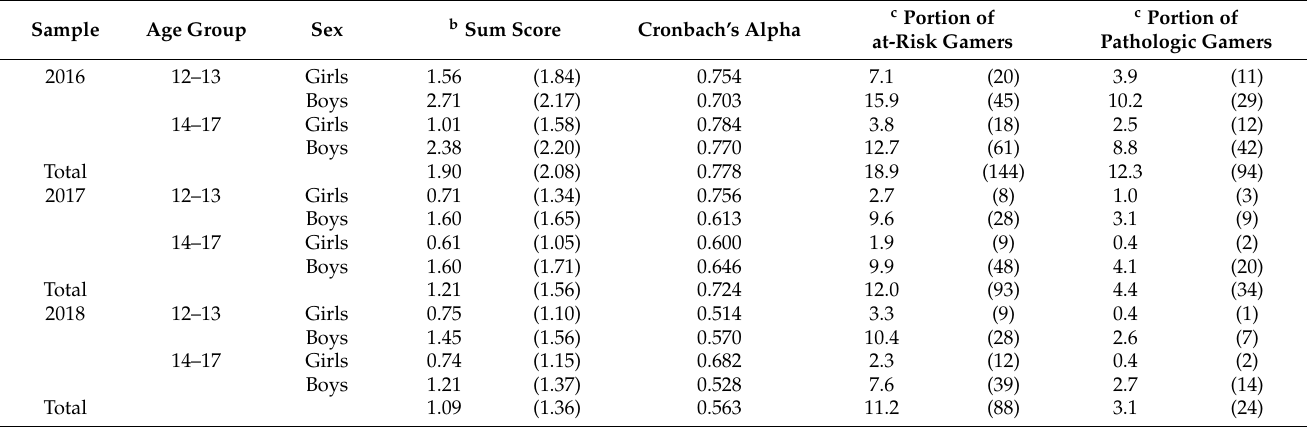
Table 2. Internet Gaming Disorder Scale (IGDS) scores, assessments, and consistency coefficients across the three samples employed a .